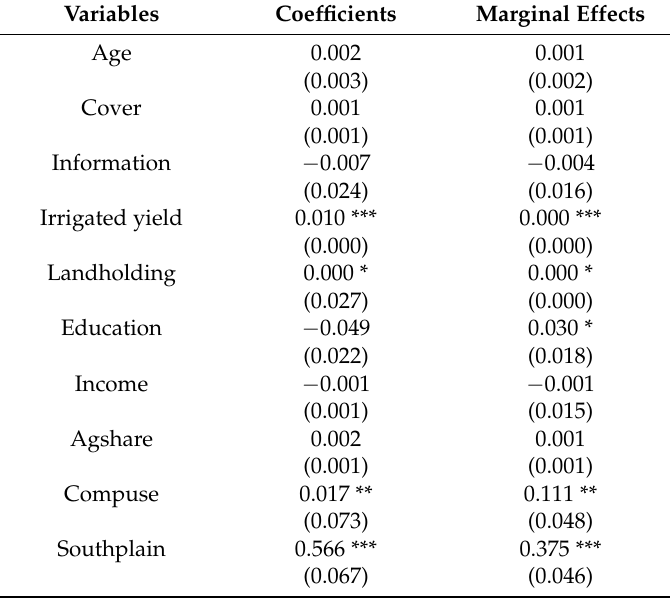
Table 4. Factors affecting the number of irrigation technologies adoption (intensity) by cotton farmers. Variables Coefficients Marginal Effects Age 0.002 0.001